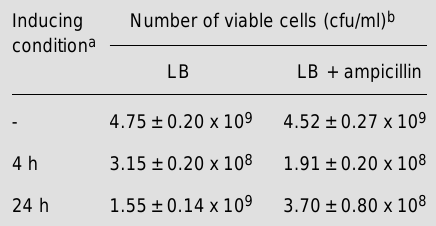
Figure 3 - Spleen persistence of S. typhimurium SL3261 and HG3 strains. BALB/c mice received a single iv dose of 10 6 cfu of SL3261 (circles) or 10 6 cfu of HG3 (squares). Mice were sacrificed and spleens removed at the times indicated. Spleen homogenates were plated onto BGA with (closed symbols) or without (open symbols) ampicillin at 100 µg/ml. Results are reported as the mean ± SD of quadruplicates from two identical